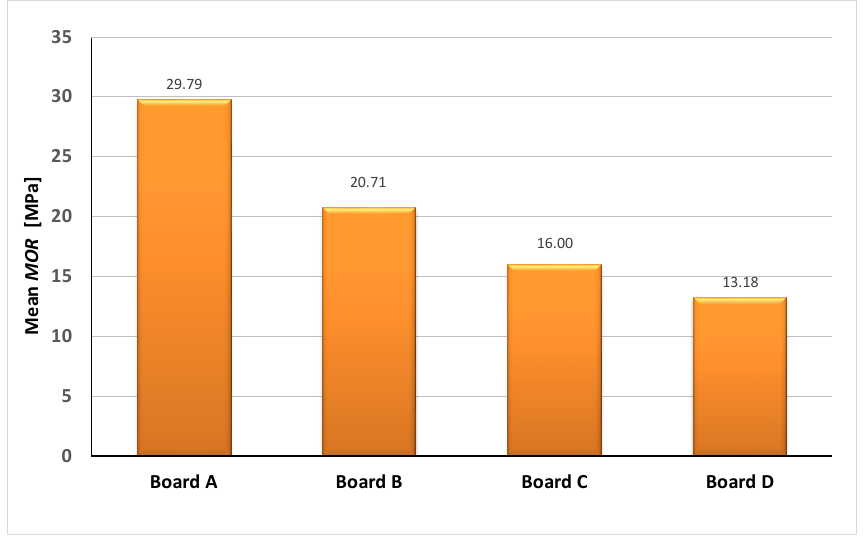
Figure 3. Mean modulus of rupture ( MOR ) of boards tested in air-dry condition.